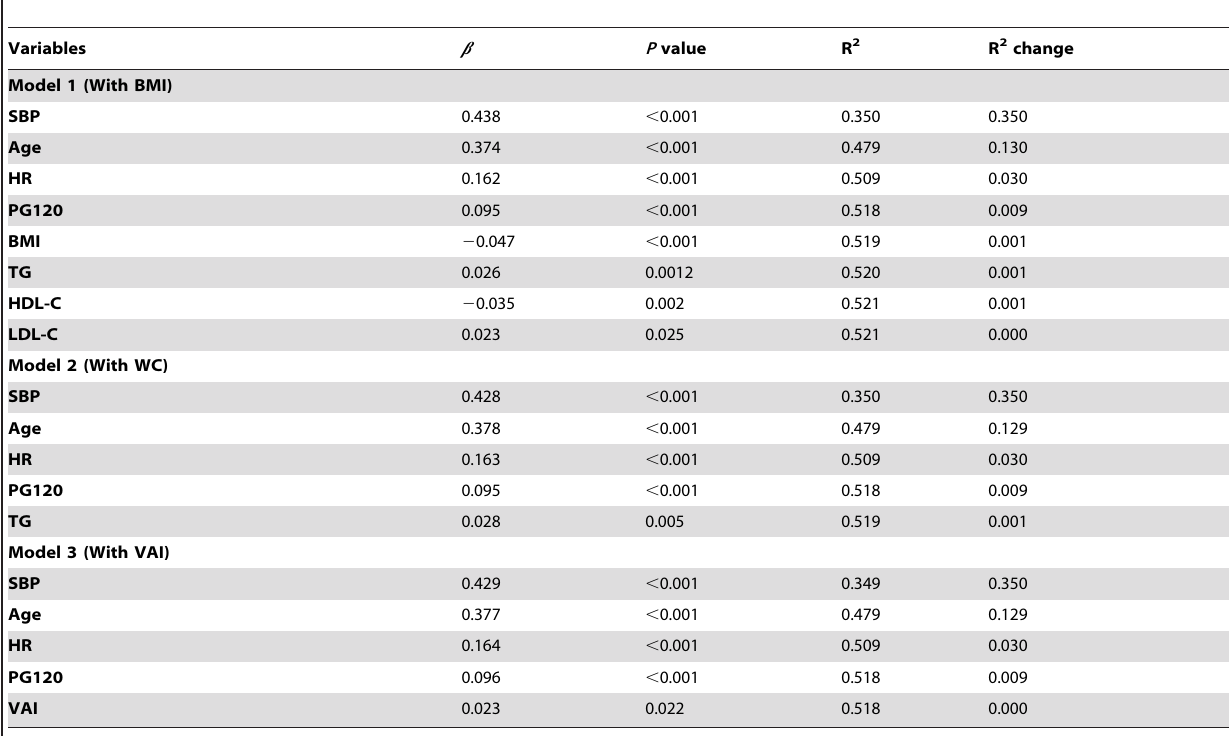
Table 2. Results of step-wise multiple regression analysis to assess the correlation of brachial-ankle pulse wave velocity with other variables in all